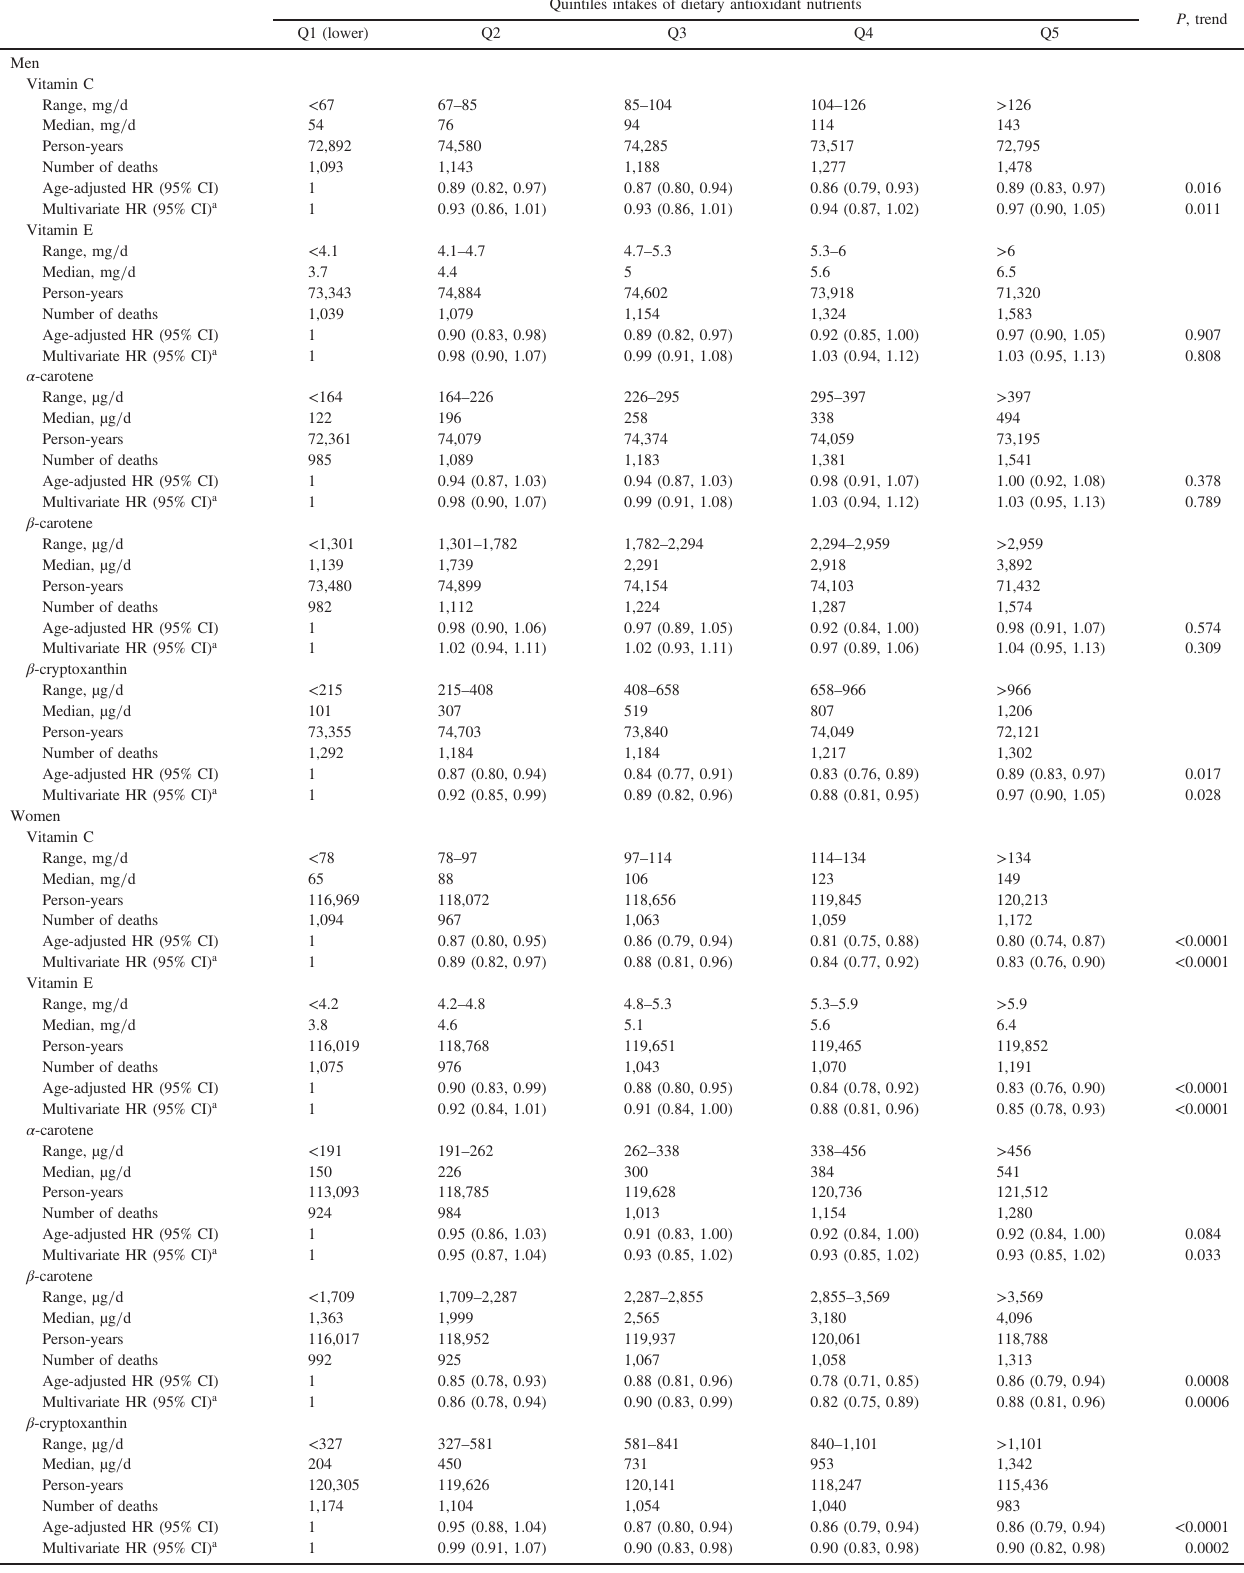
Table 2. Ranges of energy-adjusted dietary antioxidant nutrients at baseline and hazard ratios for all-cause mortality during follow-up time in men and women, JACC